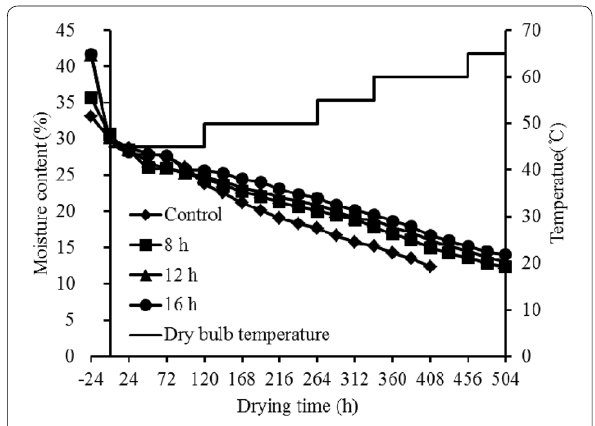
Fig. 1 Drying curves of control and pretreated